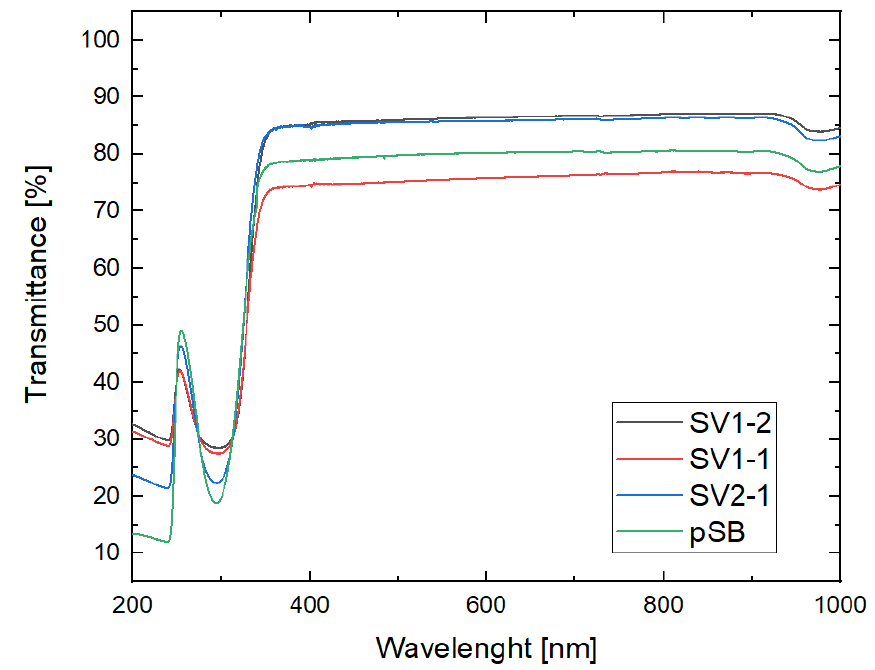
Figure 5. Transmittance spectra of TM-loaded hydrogels.